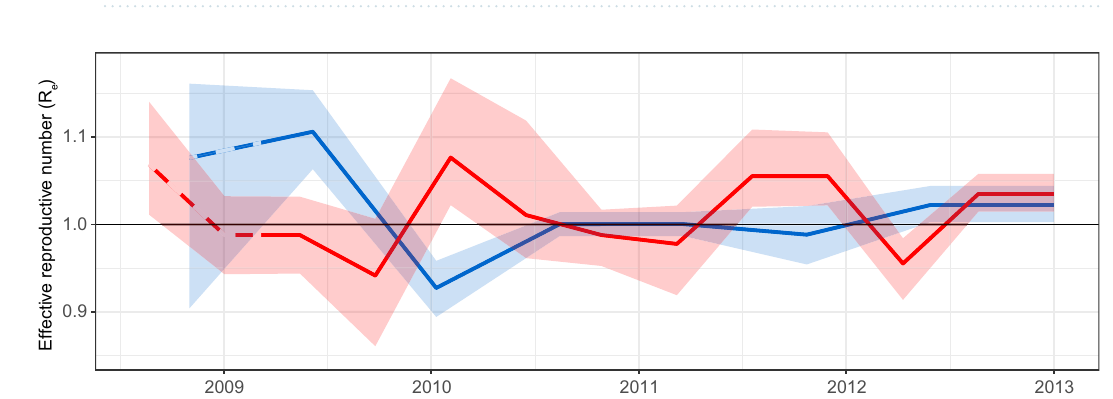
Figure 3. Oscillation of reproductive number R -skylines estimated from influenza A virus phylogenies with opposed alternation of phases between subtypes. Time-series (2009–2013) for influenza A/H1N1 (blue, n = 1078) and A/H3N2 (red, n = 1033) viruses. Pre-pandemic period is indicated with dashed lines. Shaded regions represent 95% Highest Posterior Density